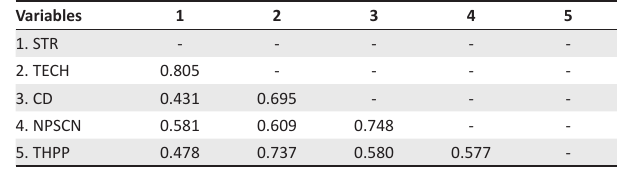
TABLE 3: Correlation results for latent